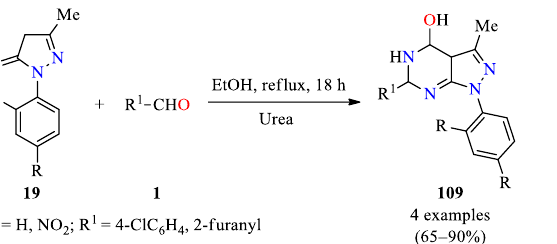
Scheme 9. Three-component synthesis of pyrazolo[3,4- d ]pyrimidin-4-ol derivatives 109 with